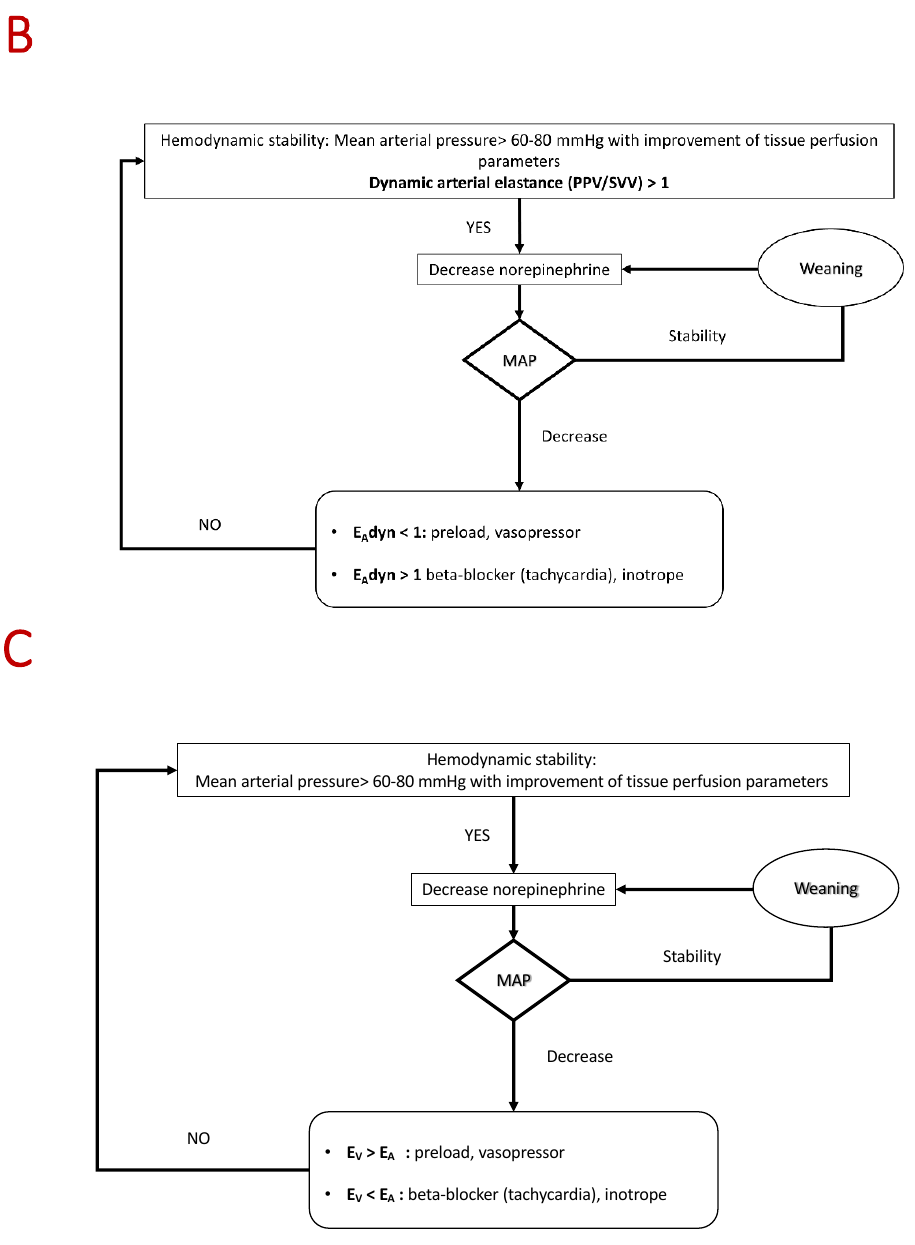
Figure 3. Algorithm proposed for vasopressor weaning. ( A ) Basic algorithm. ( B ) Advanced algorithm based on dynamic arterial elastance analysis. ( C ) Advanced algorithm based on ventriculo-arterial coupling analysis. E Adyn —dynamic arterial elastance; PPV—pulse pressure variation; SVV—stroke volume variation; E v —ventricular elastance; E A —arterial elas- tance.